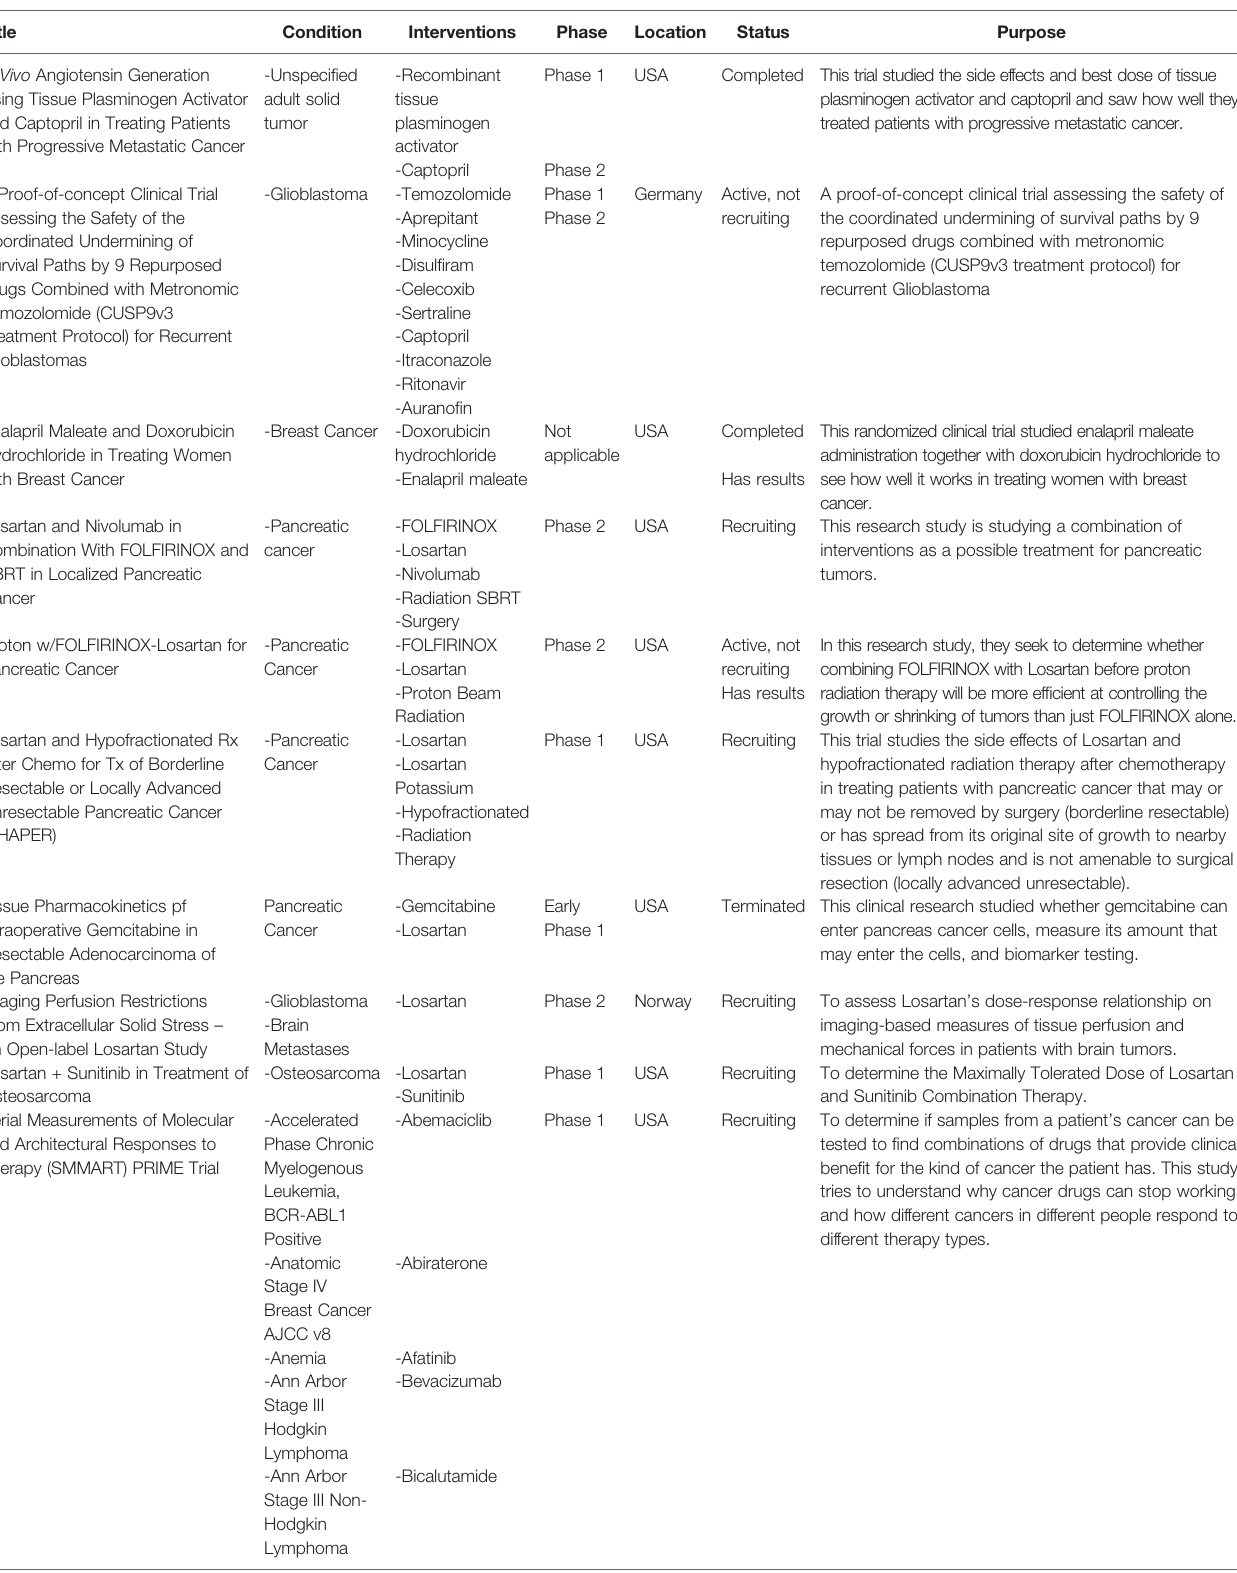
TABLE 2 | Clinical trials found in clinicaltrials.gov studying antihypertensive drugs in